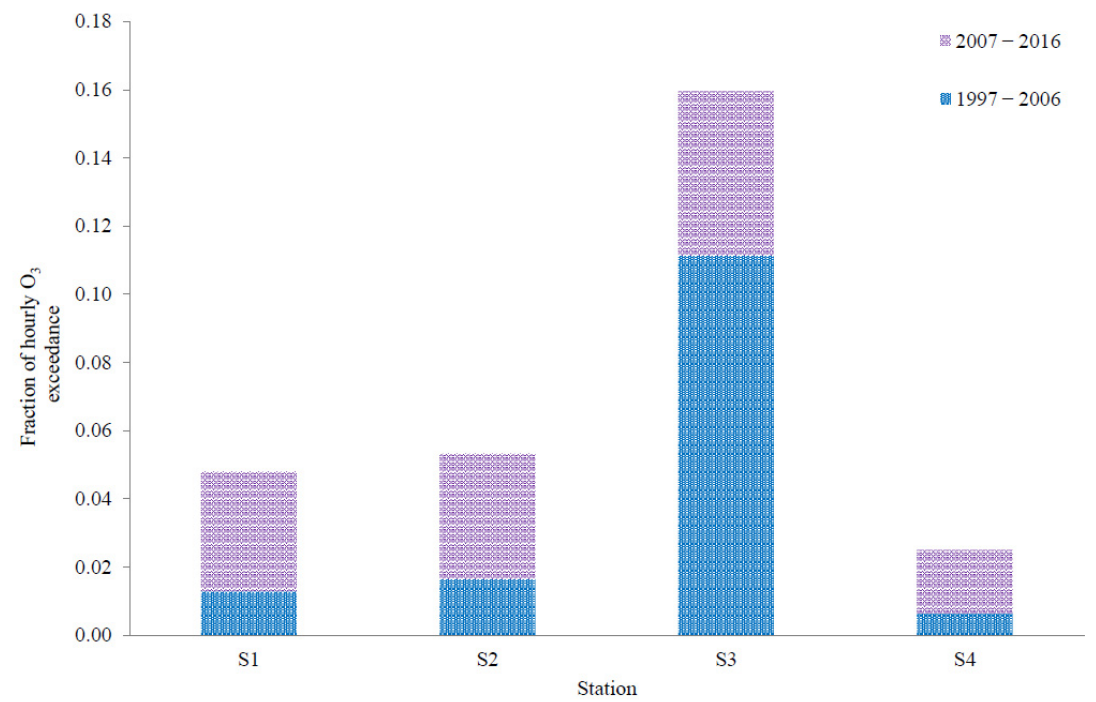
Figure 3. Fraction of hourly O 3 concentrations that were higher than 100 ppb. The fraction is calculated from total hours of O 3 exceedance divided by total available data for each station within the selected period.